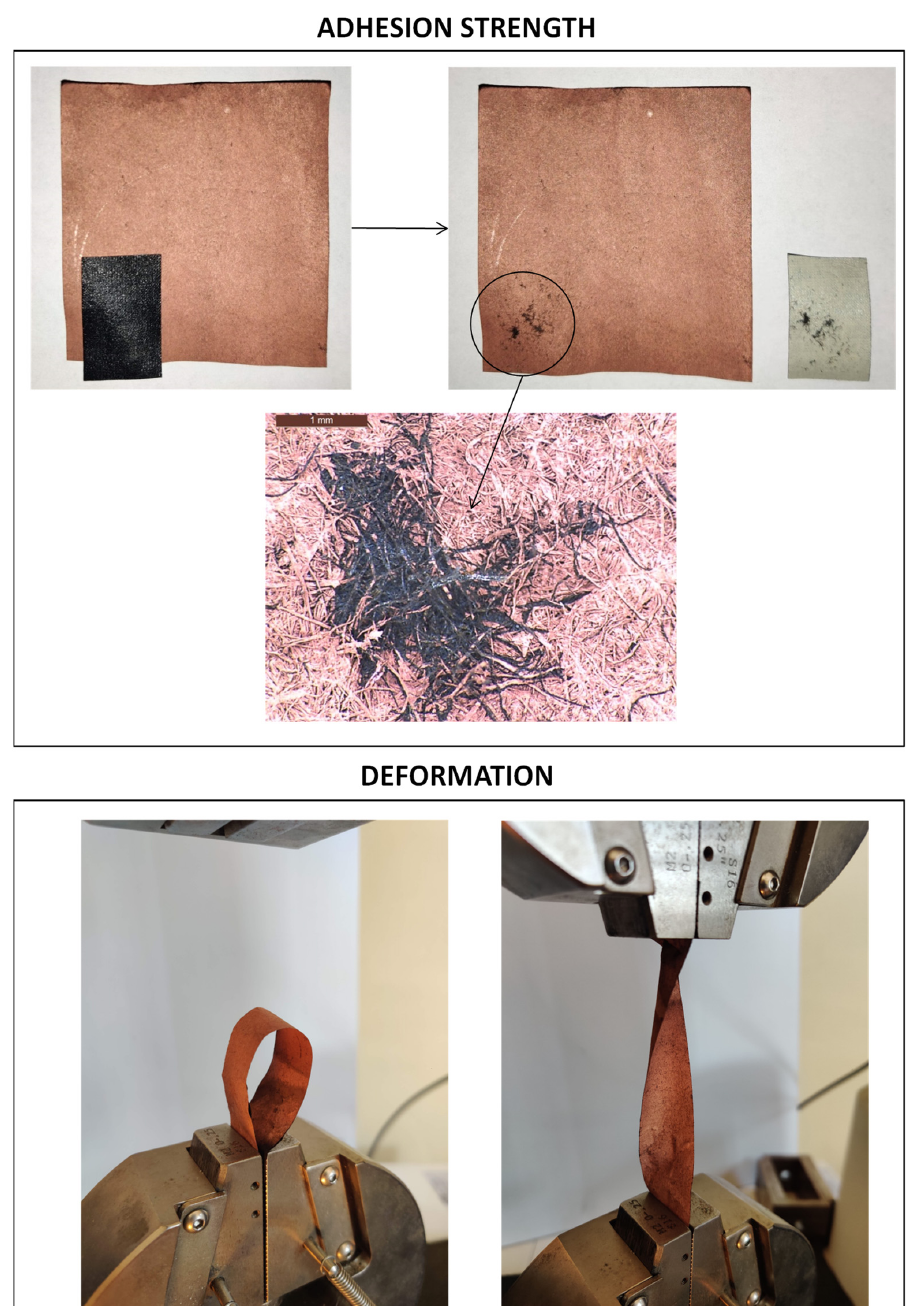
Figure 8. Adhesive strength and susceptibility to deformation of the deposited copper layer.